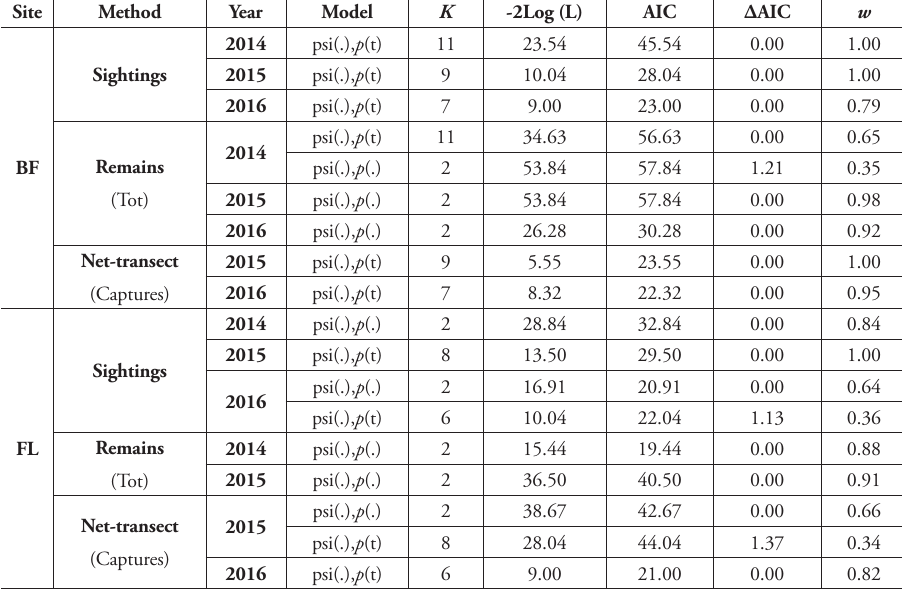
Table 6. Summary of model selection statistics for three methods, during the seasons 2014–2016 at Bosco della Fontana (BF) and Foresta della Lama (FL). K represents the number of parameters in the model and -2Log ( L ) is twice the negative log-likelihood value. Akaike Information Criteria (AIC) and Akaike weight ( w ) were calculated for each model. ∆AIC represents the difference in AIC value relative to the top model. Detection probability ( p ) may be constant (.) or vary amongst sampling occasions (t).